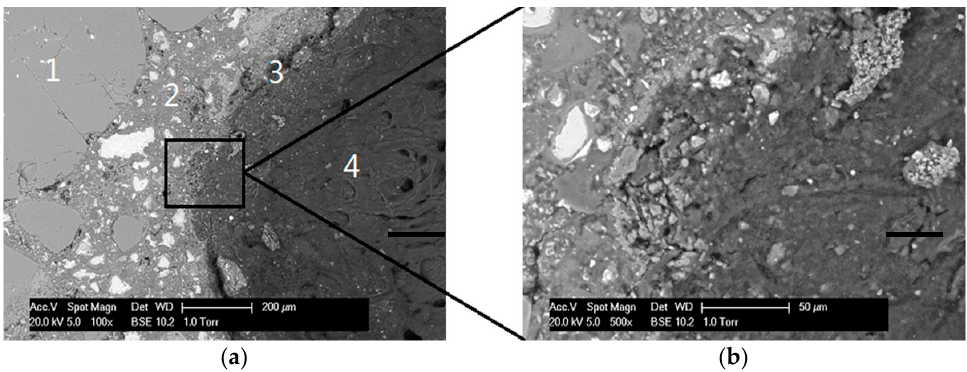
Figure 4. ESEM images showing the microstructure of interface zone between WSRP and mortar matrix at the age of 28 days. Figure ( a ) at left side highlights (1) the aggregate particles, (2) hydrated and unhydrated cement paste, (3) WSRPs and cement paste interface and (4) embedded WSRPs; Figure ( b ) at the right side shows an enlarged view of the microstructure of the interface.